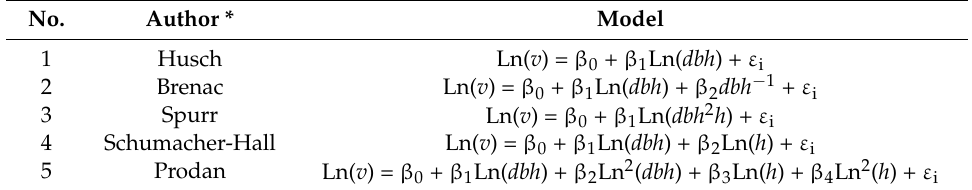
Table 2. Volumetric models tested to predict volume with bark up to 4 cm in diameter at the top of Eucalyptus clone